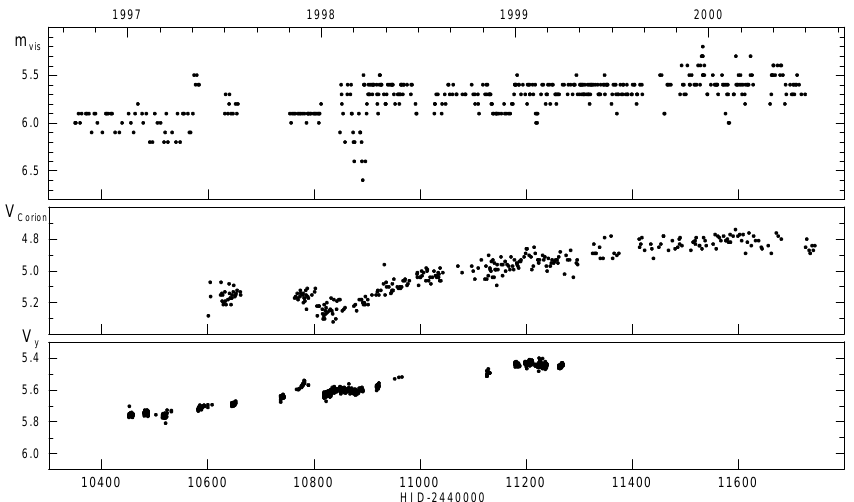
Fig. 4. Top: visual magnitude estimates of η Car, middle: CCD photometry with Corion NR-400 V filter, bottom: y -CCD photometry (23 . (cid:2)(cid:2) 0 aperture). Source: Sterken et al.